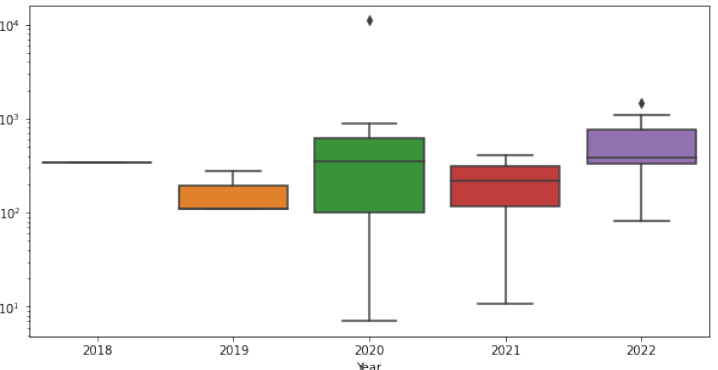
Figure 1. Reported parameter count of the largest model by year. The grey diamonds represent